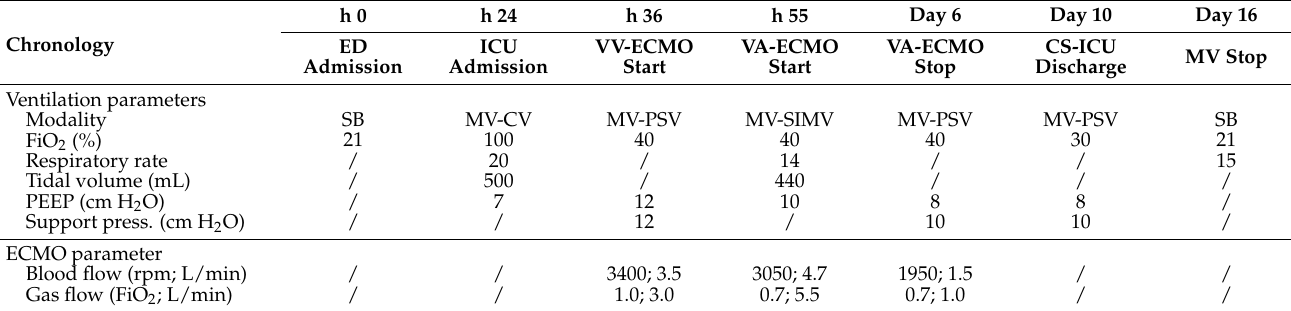
Table 2. Ventilation and ECMO parameters during the hospital